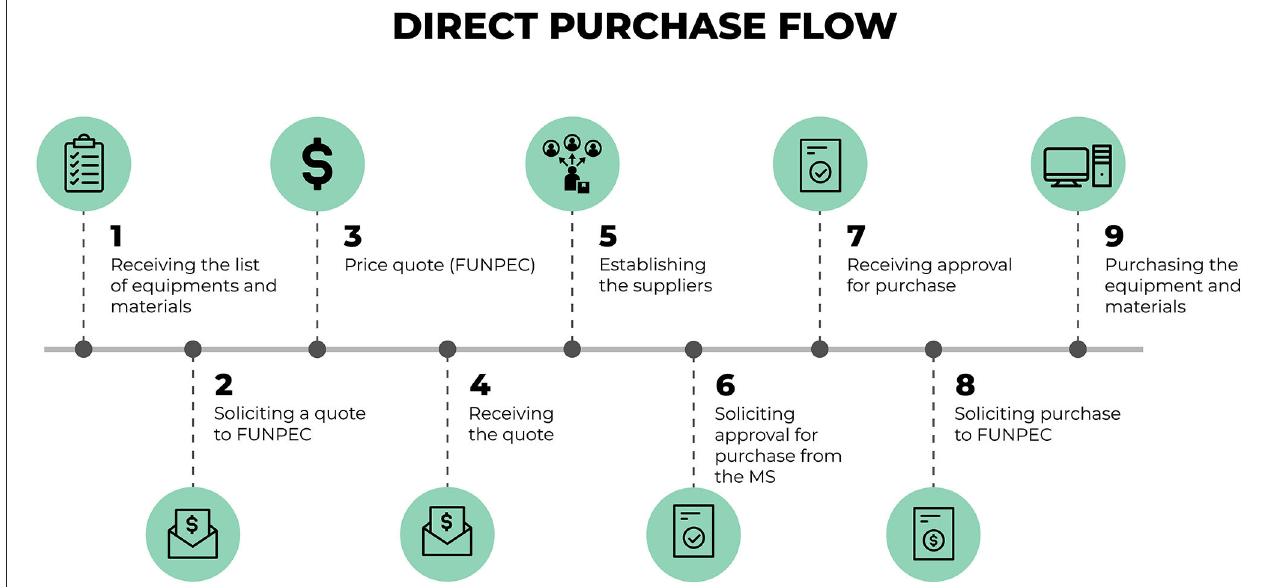
FIGURE 4 | Detailed flow for procurement through direct purchase. Source: graphic developed by the authors.